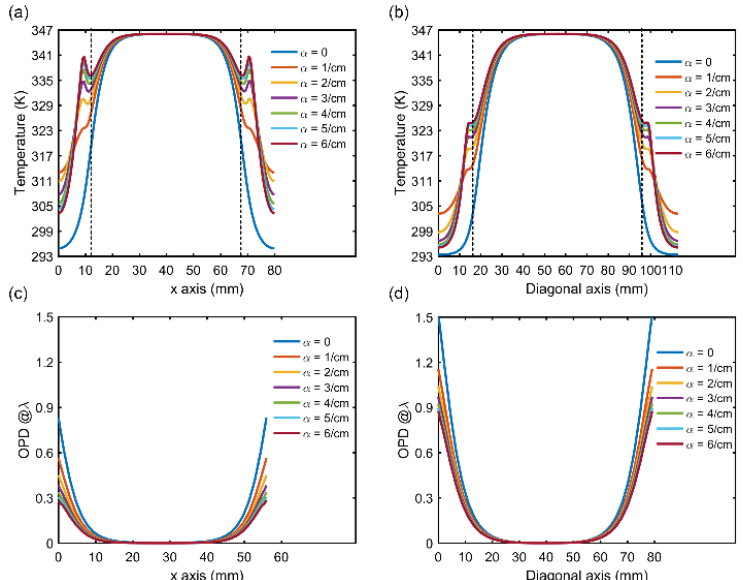
Figure 8. One-dimensional (1D) temperature and OPD as functions of α , ( a ) temperature along the centerline of the gain slab with different α , ( b ) temperature along the diagonal of the gain slab with different α , ( c ) OPD along the centerline for a single gain slab, and ( d ) OPD along the diagonal for a single gain slab.